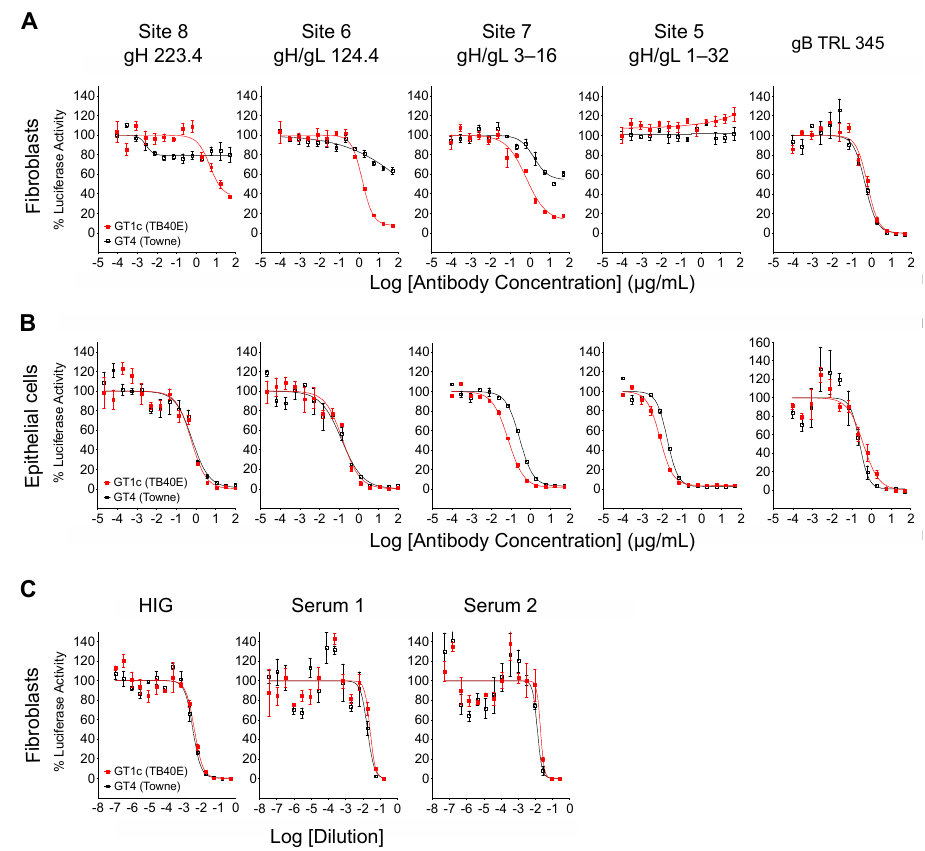
Figure 3. Towne gO impairs fibroblast entry neutralization by mAbs targeting three independent gH/gL epitopes but does not impact net neutralizing activities of anti-CMV antibodies induced by natural infection. Viruses GT1c or GT4 were incubated for 1 h at 37 °C with serial dilutions of mAbs, HIG, or human sera, then added in triplicate to 96-well cultures of MRC-5 fibroblasts ( A , C ) or ARPE-19 epithelial cells ( B ). After incubation at 37 ◦ C for 48 h, luciferase activity in each well was measured and the % of maximal luciferase activity (means of triplicate wells) was plotted vs. log of antibody concentration or dilution. Table 2. IC 50 concentrations ( µ g/mL) 1 for mAb neutralization of fibroblast (F) or epithelial (E) cell